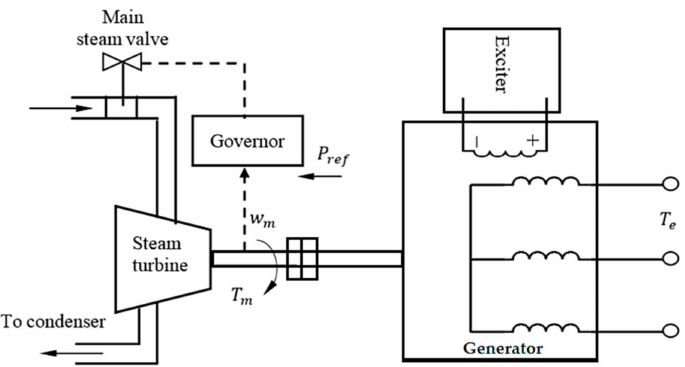
Figure 2. Block diagram of a synchronous generator (Reprinted with permission from ref.